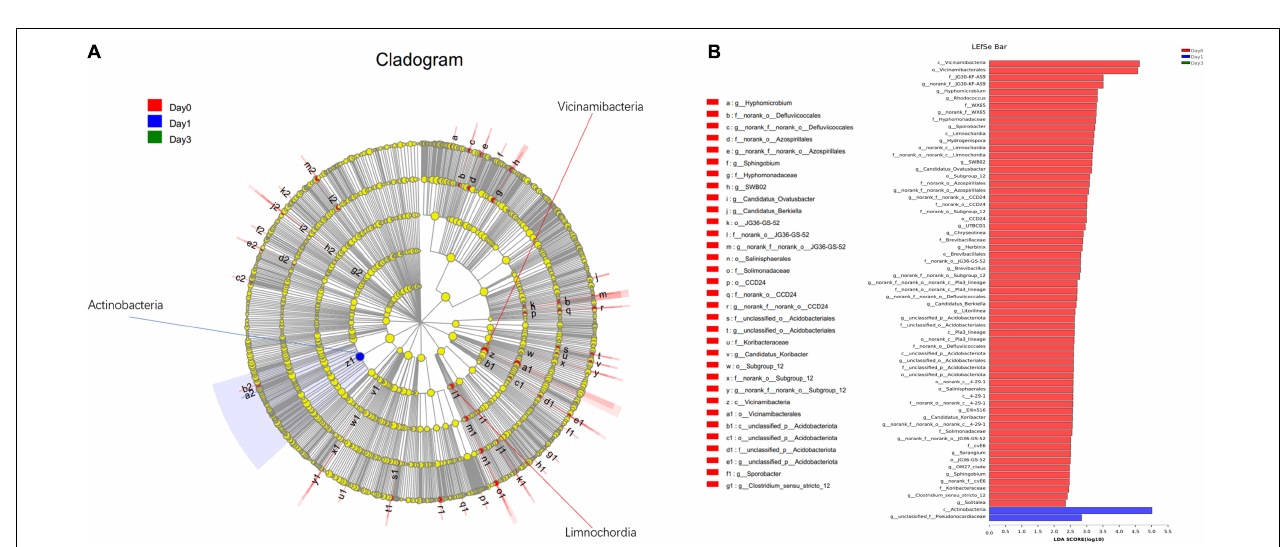
FIGURE 5 | Bacterial genera with significant change of relative abundance between different sample groups. (A) Bacterial difference between Day 0 and Day 1. (B) Bacterial difference between Day 0 and Day 3.